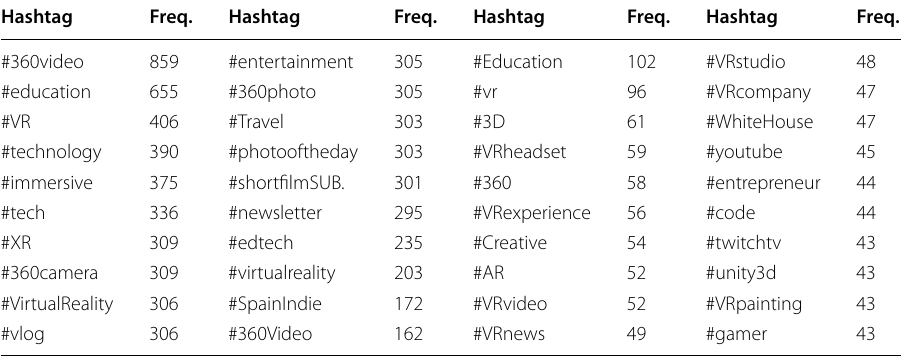
Table 10 Frequency of the top-40 most commonly used hashtags within the Tweets in the years of